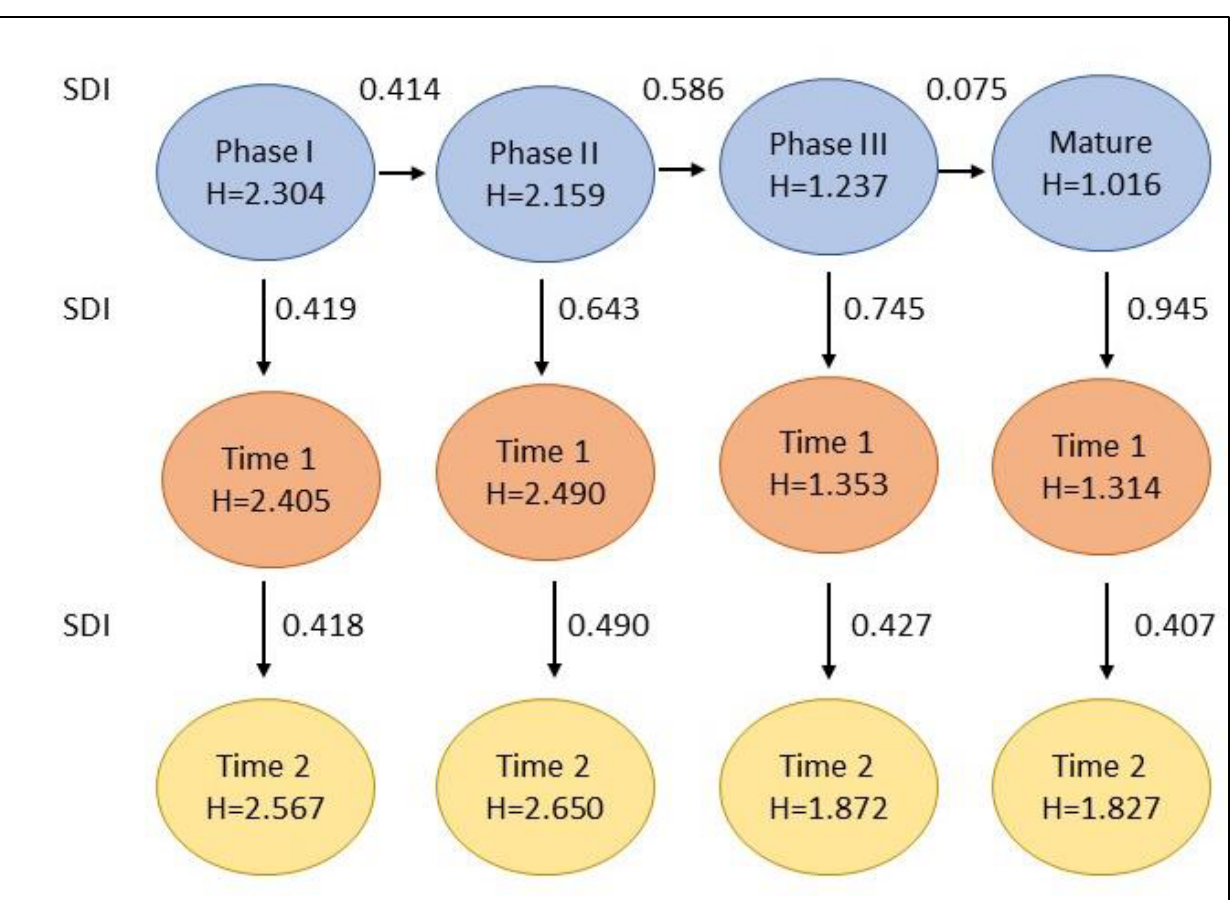
Figure 5. Average of Shannon’s Diversity Index (H’) for plots by woodland successional phase pre-fire (blue circles), 5–6 years after the wildfire (Time 1, orange circles middle row) and 12–13 years after the wildfire (Time 2, yellow circles bottom row). Sorensen’s Dissimilarity Index (SDI) is a measure of dissimilarity or species turnover along the successional gradient and following the wildfire. High values represent high turnover of species. The largest observed change along the woodland development gradient is seen between Phase II and III. Species turnover because of the fire increased along the successional gradient with almost a complete replacement of the plant community in the Mature woodlands (SDI = 0.945).